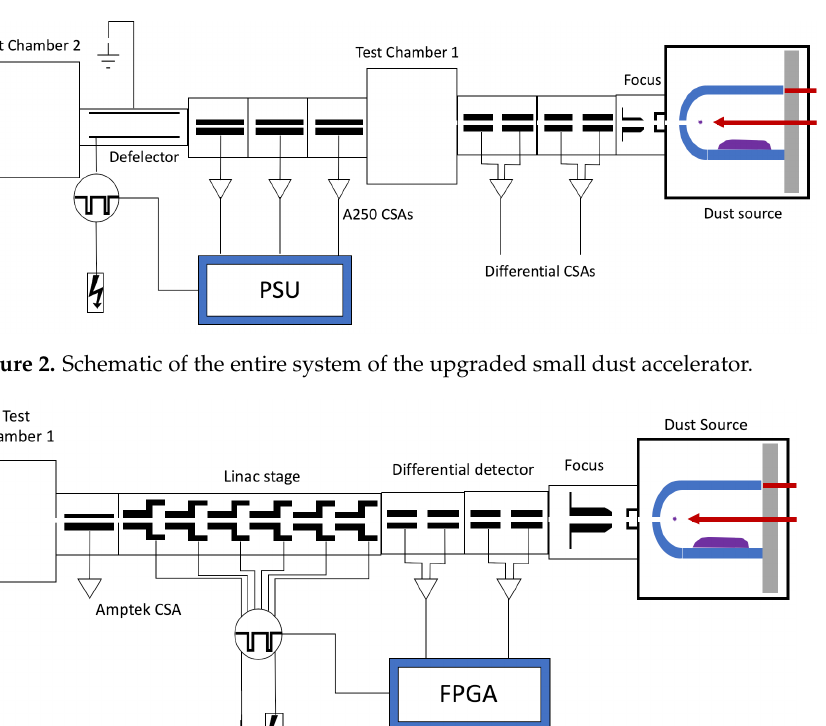
Figure 1. Small dust accelerator with short beam line. The high voltage generator (Brandenburg 2807 Alpha Serial II) produces an acceleration voltage up to 30 kV. The dust source is operated in air condition and no protection gas (such as SF6) is required. The beam line itself is evacuated to a vacuum of better than 10 − 6 mbar using a turbo molecular pump.